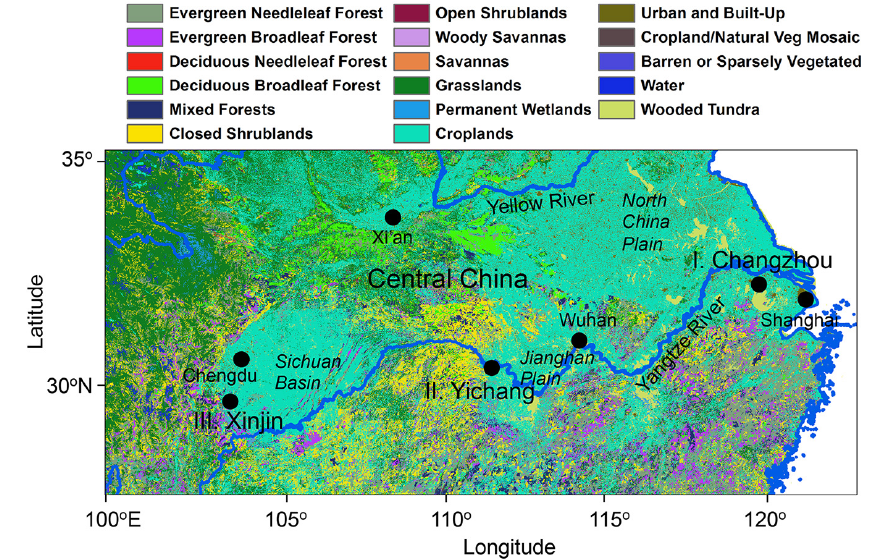
Fig. 7. Spatial distribution of vegetation cover in central China. The original data were derived from a Multi-source Integrated Chinese Land Cover (MICLCover) map (Ran et al.,